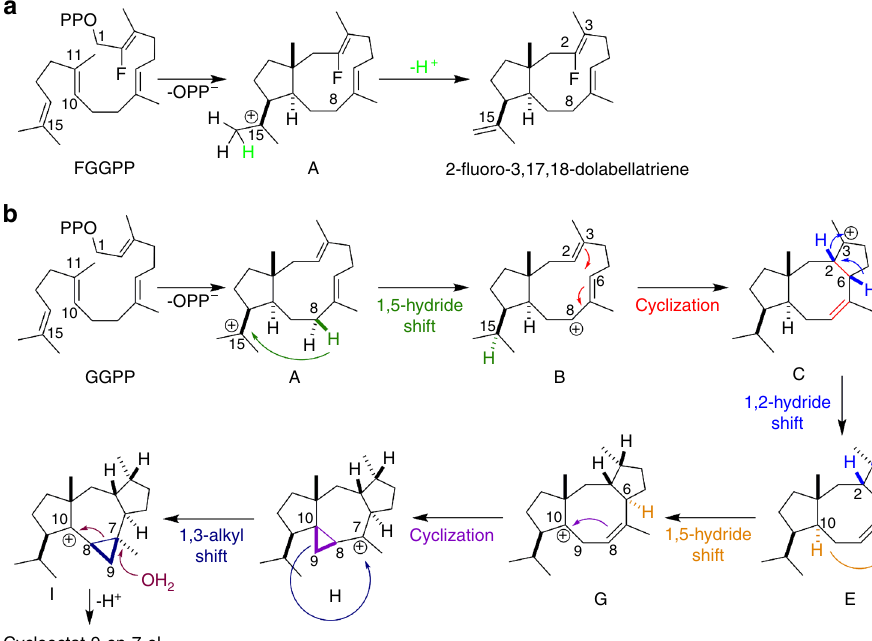
Fig. 3 Proposed mechanism of CotB2 wt . a Conversion of FGGDP to F-Dola. b Proposed catalytic mechanism in CotB2, as obtained in the literature from isotope labelling experiments